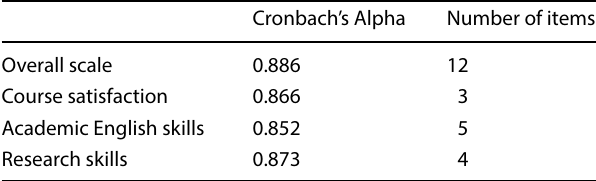
Table 5 The internal consistency analysis